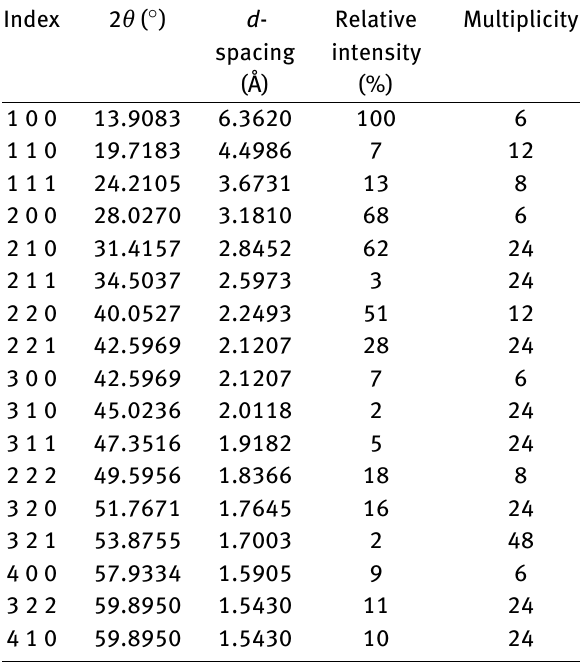
Table 9: Calculated X-ray diffraction parameters of cubic α - HC(NH 2 ) 2 PbI 3 . Equivalent indices were combined. For space